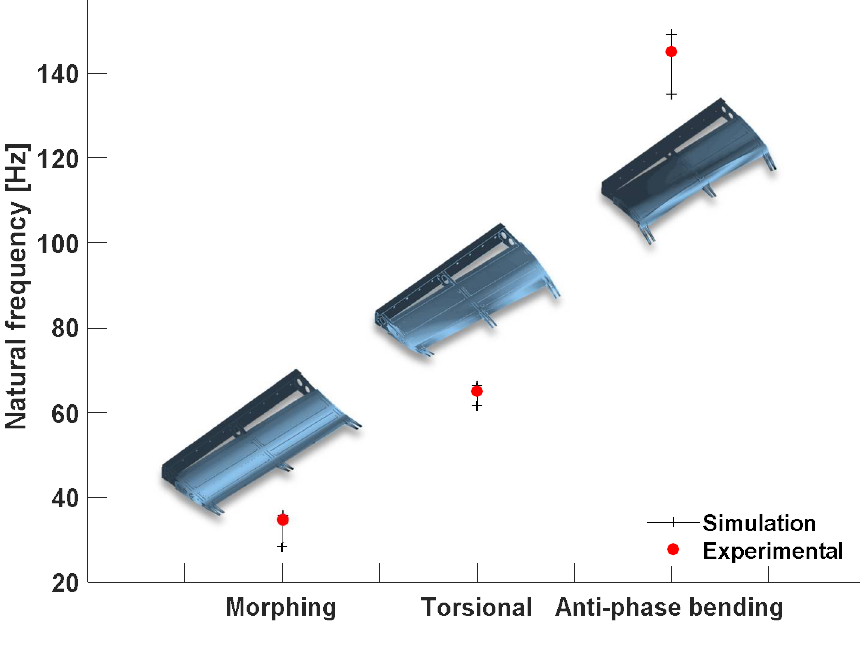
Figure 25. Test—FEM results deviation.